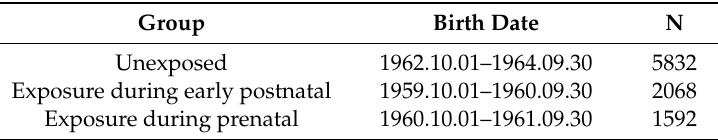
Table 1. Grouping of research objects and